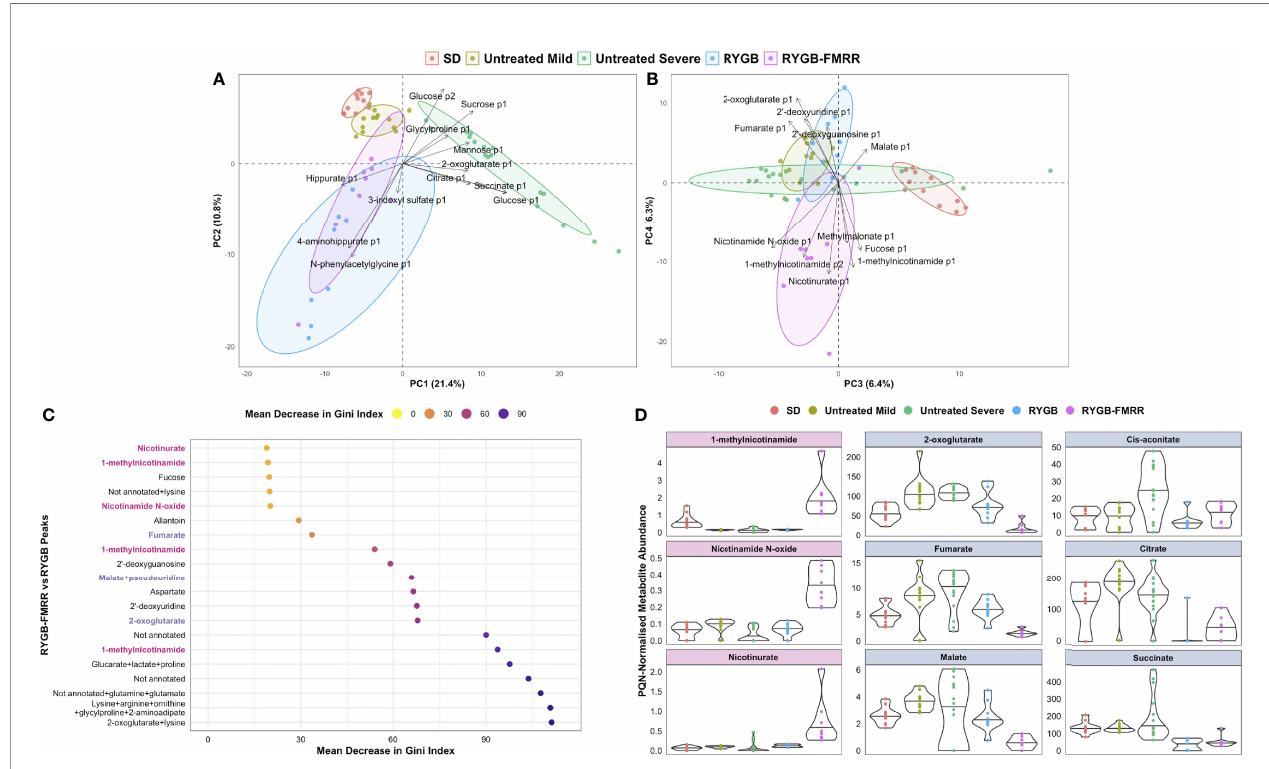
FIGURE 6 | Characterization of urinary metabolomic changes following RYGB and RYGB-FMRR. (A, B) Principal component analysis biplots of PQN-normalized urinary 1 H-NMR peaks obtained before and at 4 weeks after intervention (A, principal components 1-2; B, principal components 3-4). Baseline and follow-up samples from SD rats were considered together given the lack of change in metabolomic pro fi les evident in this group. Samples from SHAM rats at baseline and follow-up were considered alongside baseline samples from RYGB and RYGB-FMRR rats, and collectively designated as untreated ZDSD rats. Untreated ZDSD rats clustered based on disease severity into two subphenotypes, mild and severe, rather than by timing of sampling or by experimental group assignment. The de fi nition of disease severity in this context was based on patterns of urinary metabolomic changes in fl uencing subphenotypes observed after clustering of rats by principal component analysis. RYGB and RYGB-FMRR re fl ect post-intervention values in these two groups. Arrows indicate loading vectors of metabolites driving separation of the groups along principal components 1-4. (C) Dotplot of urinary 1 H-NMR peaks ranked by importance to classi fi cation of RYGB and RYGB-FMRR groups in random forest modelling (70). Peaks are displayed in descending rank order from left to right according to the variable importance metric, mean decrease in Gini index. Variable importance estimates are mean values derived from 100 model repetitions. Multiple peaks were identi fi ed for certain metabolites and some peaks remained unannotated despite 2-D NMR analysis. When multiple metabolites are present in a given peak, metabolites are listed in order of relative abundance in the peak, with the most abundant metabolite listed fi rst. PPAR a biomarker metabolites involved in nicotinamide metabolism are highlighted in pink; TCA cycle intermediates are highlighted in blue. (D) : PQN-normalized abundance of metabolites according to the groups outlined in the PCA biplots in (A, B) The fi rst column re fl ects PPAR a biomarker metabolites involved in nicotinamide metabolism (pink panels). The second and third columns re fl ect TCA cycle intermediates (blue panels). The raw spectra and spectral processing in the R package Speaq was manually reviewed for these metabolites to ensure that the between-group differences highlighted are not artefactual (64). Illustrative examples of the raw spectra and spectral processing in Speaq for the 1-methylnicotinamide and 2-oxoglutarate peaks are presented in Supplemental Figure 1 . NMR characteristics of the peaks are presented in Supplemental Table 1 . 1 H-NMR, proton nuclear magnetic resonance spectroscopy; 2-D, two-dimensional; p1, peak 1; p2, peak 2; PC, principal component; PQN, probabilistic quotient normalization; RYGB, Roux-en-Y gastric bypass; RYGB-FMRR,